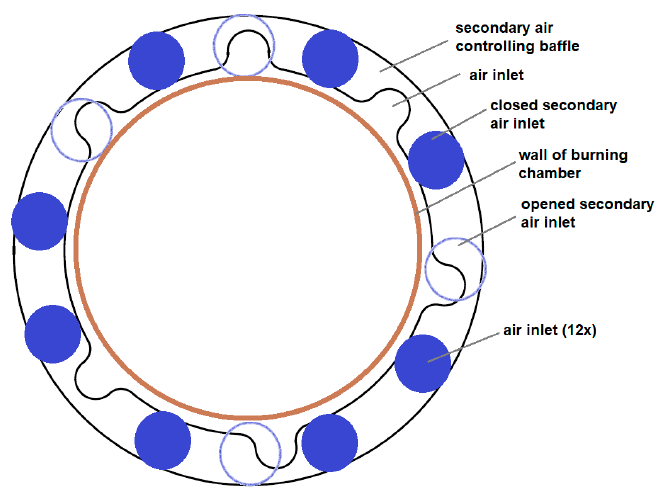
Figure 4. Secondary-air-controlling aperture.